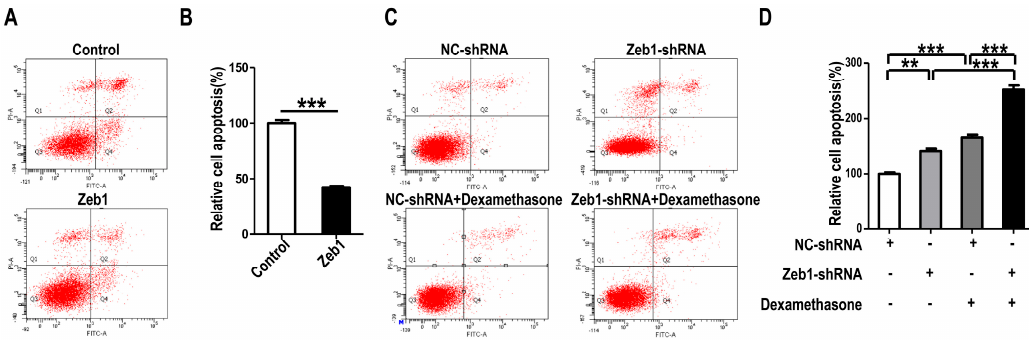
Figure 3. Knock-down of Zeb1 promotes mK3 cell apoptosis while overexpression of Zeb1 inhibits it. ( A ) mK3 cell apoptosis was detected by flow cytometry with Annexin V-FITC/PI staining. The number of positive cells double stained by AnnexinV-FITC/PI in mK3 cells transfected with Zeb1 overexpression vector was dramatically smaller than the control vector. The detection was performed 48 h transfection later; ( C ) mK3 cells were transfected with Zeb1 -shRNA or negative control shRNA for 20 h. Then one well cells of the two transfected with the same vector was treated with 0.1 μ M dexamethasone for 30 h, following by cell apoptosis detection. The number of AnnexinV-FITC/PI-positive cells in Zeb1 knock-down mK3 cells was significantly larger than the negative control cells. And the dexamethasone at 0.1 μ M concentration increased the number of AnnexinV-FITC/PI-positive mK3 cells; ( B , D ) Apoptosis rates (Q2% + Q4%) of mK3 cells detected in Figure 3A,B were respectively quantified. Results were displayed as mean ± SD ( n = 3). ** p < 0.01, *** p < 0.001 negative control vector.